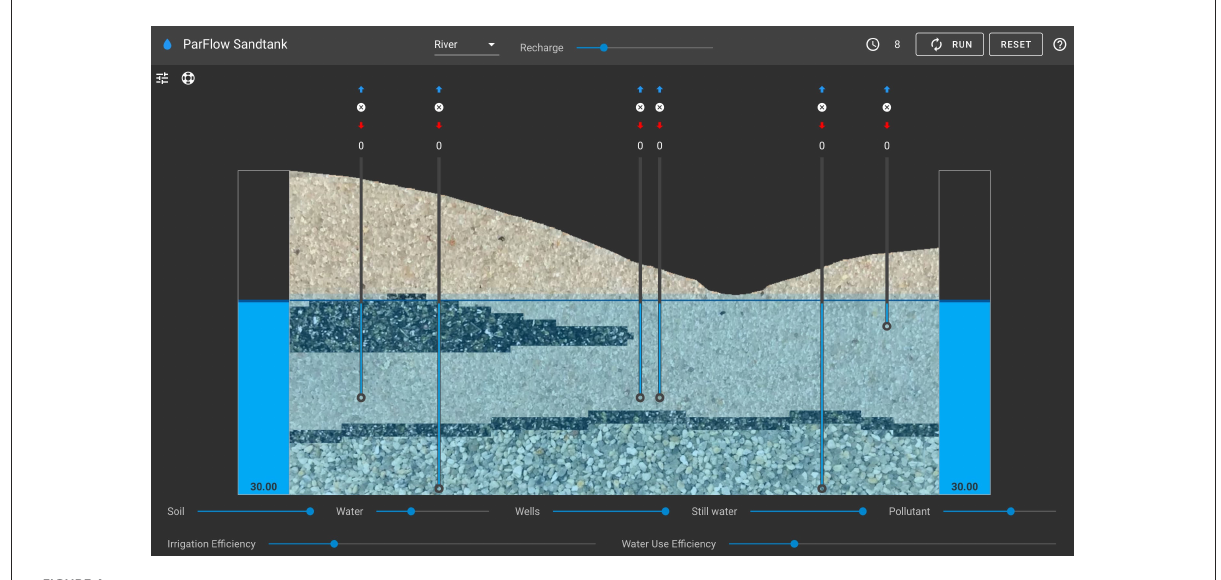
FIGURE4 The ParFlow Sandtank Agrosystem custom